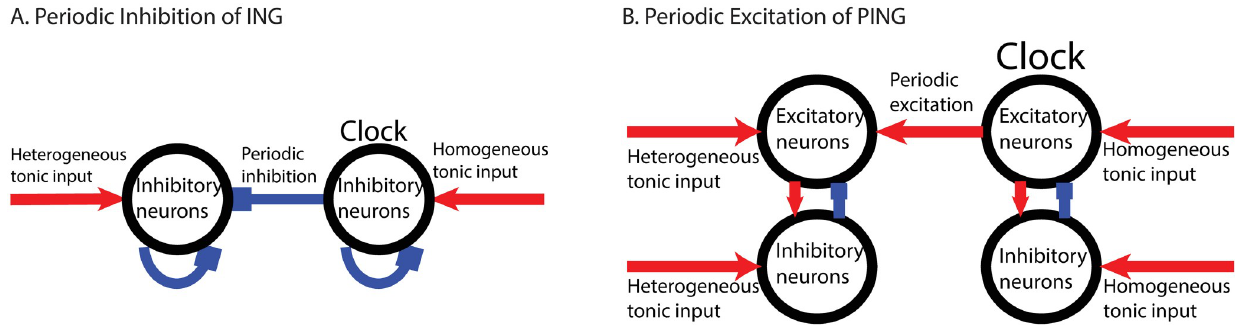
Fig 4. Sketch of computational models. (A) ING rhythm receives periodic inhibitory input generated from another ‘clock’ ING rhythm. (B) PING rhythm receives periodic excitatory input by its E-population generated from another ‘clock’ PING rhythm.